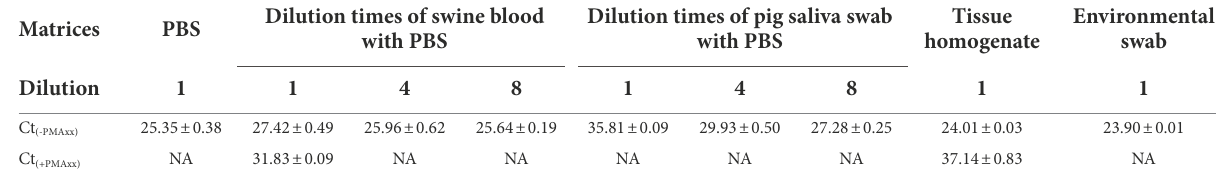
TABLE 4 Detection of inactivated ASFV suspended in different matrices by qPCR (Ct (-PMAxx) ) and Triton X-100-PMAxx-qPCR (Ct (+PMAxx) ) assays. Undiluted blood and saliva had later Ct values compared to PBS indicative of qPCR inhibition. These values improved after 4× and 8× dilution in PBS. Undiluted blood (1×) could also interfere with the Triton X-100-PMAxx-qPCR assay as an earlier Ct value was observed. Tissue homogenate and environmental swab had no effects on both assays. Dilution times of swine blood Dilution times of pig saliva swab Matrices PBS with PBS with